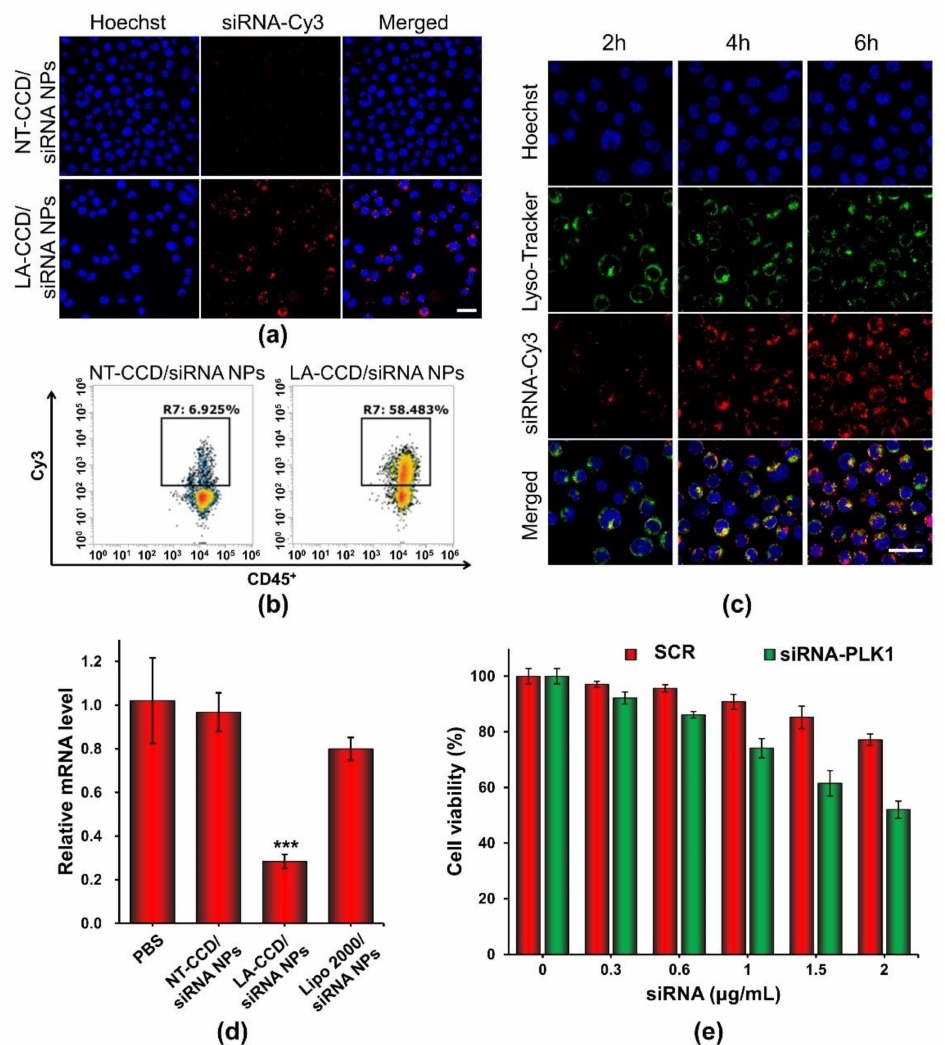
Figure 13. Cellular uptake of NT-CCD/siRNA NPs and LA-CCD/siRNA NPs were observed by ( a ) CLSM and quantified by ( b ) flow cytometry assays. Scale bar, 25 µ m. ( c ) Lysosomal escape of LA-CCD/siRNA NPs. Scale bar, 25 µ m. The cell nuclei were stained blue with Hoechst 33324, and lysosomes were labeled with the green fluorescence dye LysoTracker™ Green. The relative mRNA level and protein expression of the PLK1 gene in THP-1 incubated with various nanoparticles for 48 h were detected by ( d ) qRT-PCR assay. *** p < 0.001. ( e ) Cytotoxicity of LA-CCD/siRNA NPs with various siRNA concentrations to THP-1 cells. Data are shown as the mean ± SD (n =